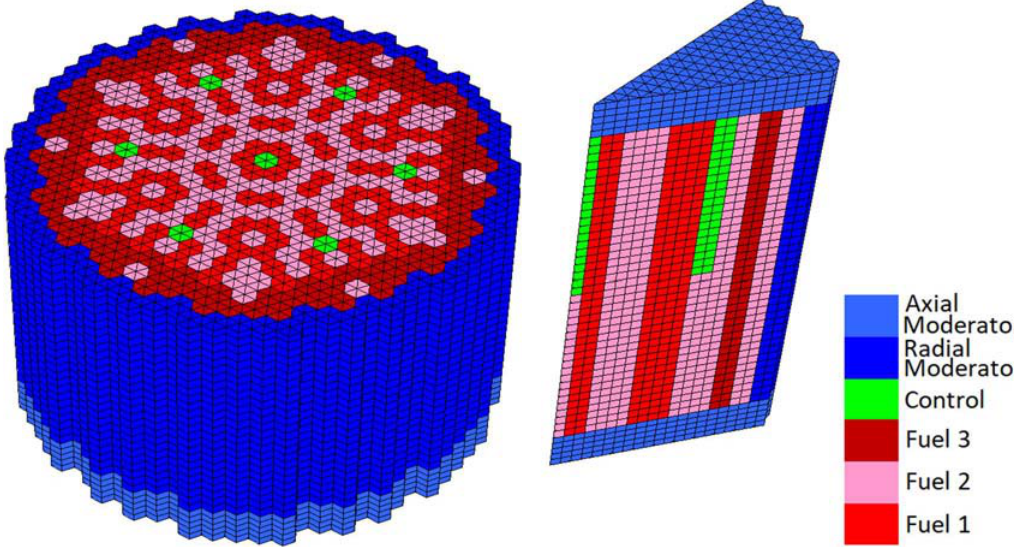
Figure 5. VVER-440 Benchmark